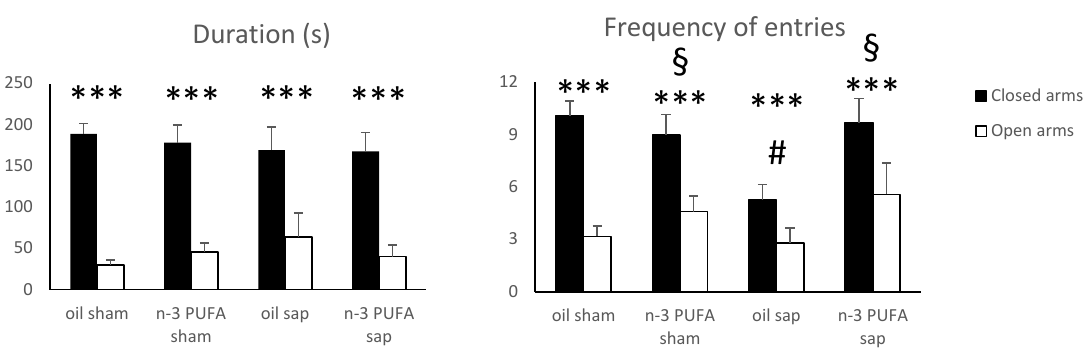
Figure 2. Elevated Plus Maze data. Duration and frequency of exploration of the closed and open arms in the four experimental groups. Data are reported as mean and SEM (oil sham, n = 12; n-3 PUFA sham, n = 10; oil sap, n = 10; n-3 PUFA sap, n = 10). Arm e ff ect: *** p < 0.000001; Diet e ff ect: § p < 0.05; Diet x lesion e ff ect: # p <